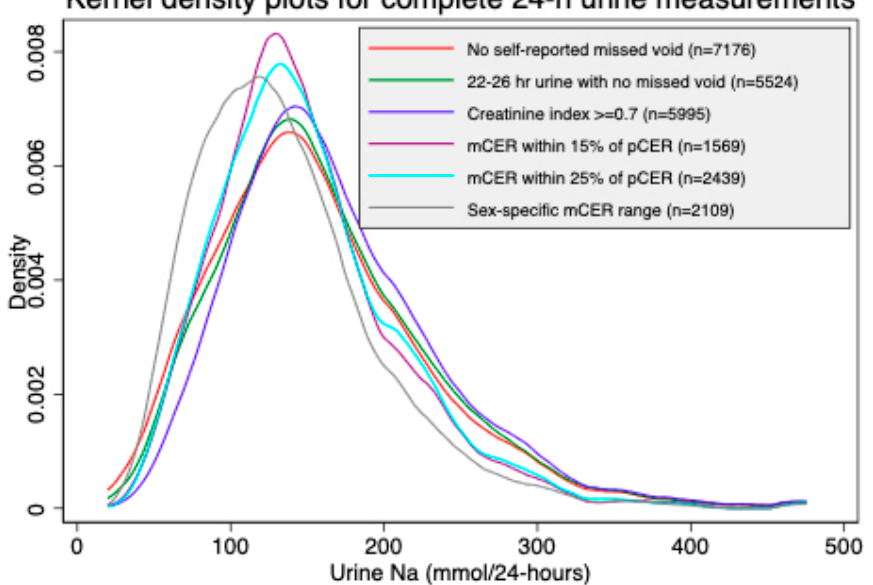
Figure 1. Kernel density plots of measured 24-h urine sodium excretion based on different methods of calculating complete 24-h urine samples. mCER: measured 24-h urine creatinine. excretion; pCER: predicted 24-h urine creatinine excretion. Table 2. Sex-specific 24-h urine volume and 24-h urine creatinine concentrations (mg / dL) from di ff erent methods of evaluating the completeness of 24-h urine